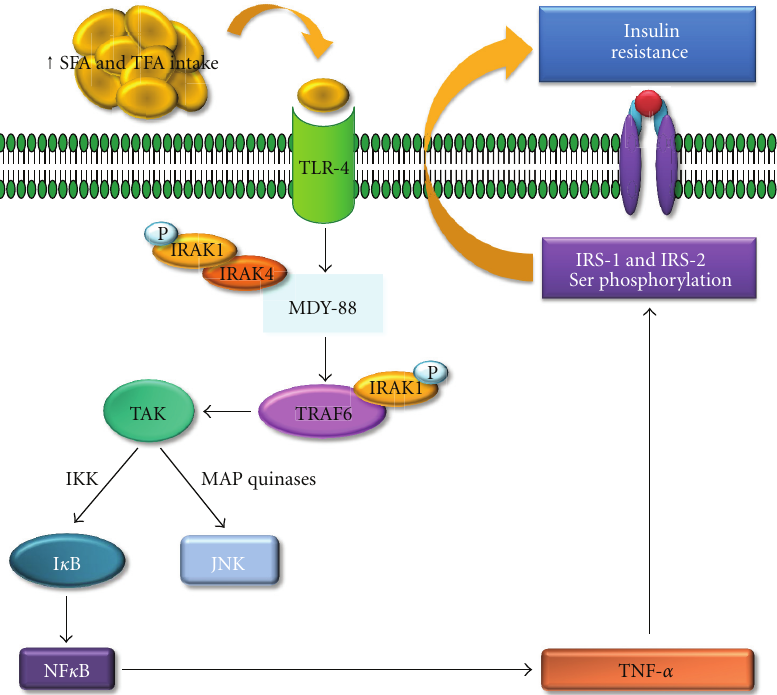
F 3: Schematic representation of SFA and TFA excess intake effects in the mechanisms of insulin resistance development. IKB: inhibitor of nuclear factor- B, IKK: inhibitor of nuclear factor- 𝜅𝜅 𝜅𝜅